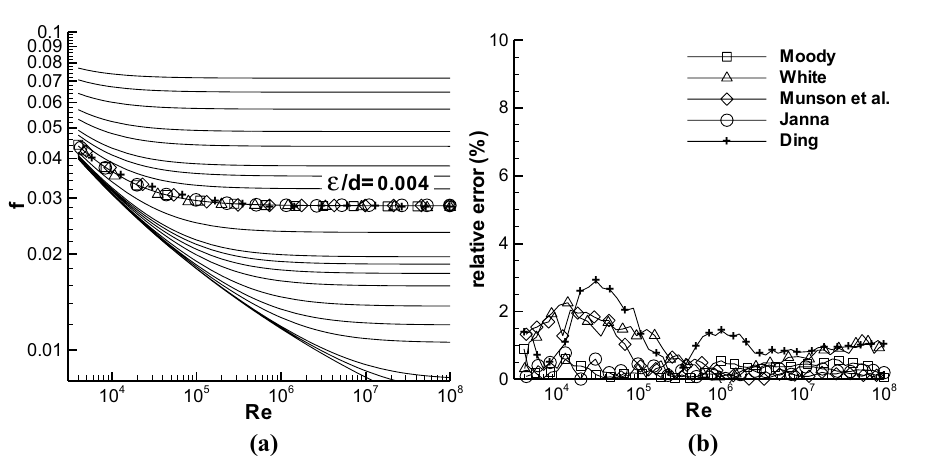
Figure 2. ( a ) The Moody chart in the turbulent region calculated with the Colebrook equation, together with the f data at ε/d = 0.004 obtained from four textbooks 3–6 and the paper of Moody 1 . The ε/ds adopted are the same as those in Fig. 1. The symbols are the data in the references. ( b ) The deviation between the calculated f and the data in Refs. 1,3–6 at ε/d = 0.004. The symbols in ( a ) are the same as in ( b